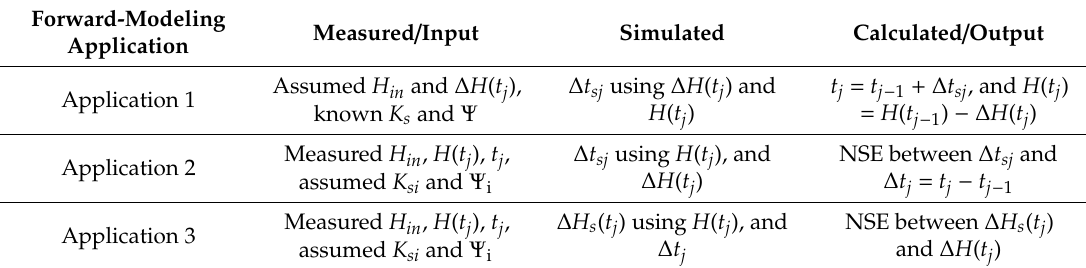
Table 1. The three di ff erent applications of the forward